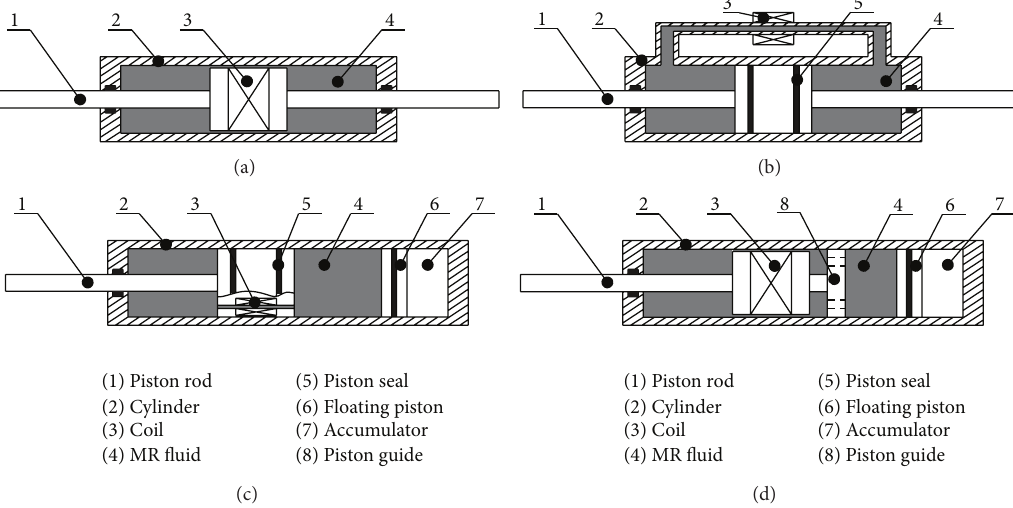
Figure 2: Available MR dampers designs: (a) a double-ended valve and shear mode one, (b) a double-ended bypass valve mode one, (c) a single-ended valve mode one, and (d) a single-ended valve and shear mode